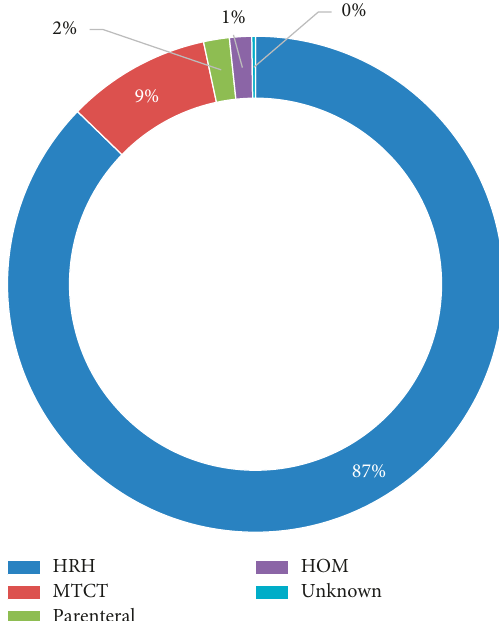
Figure 2: Redefined mode of transmission of reported HIV cases from 1993 to 2020 in